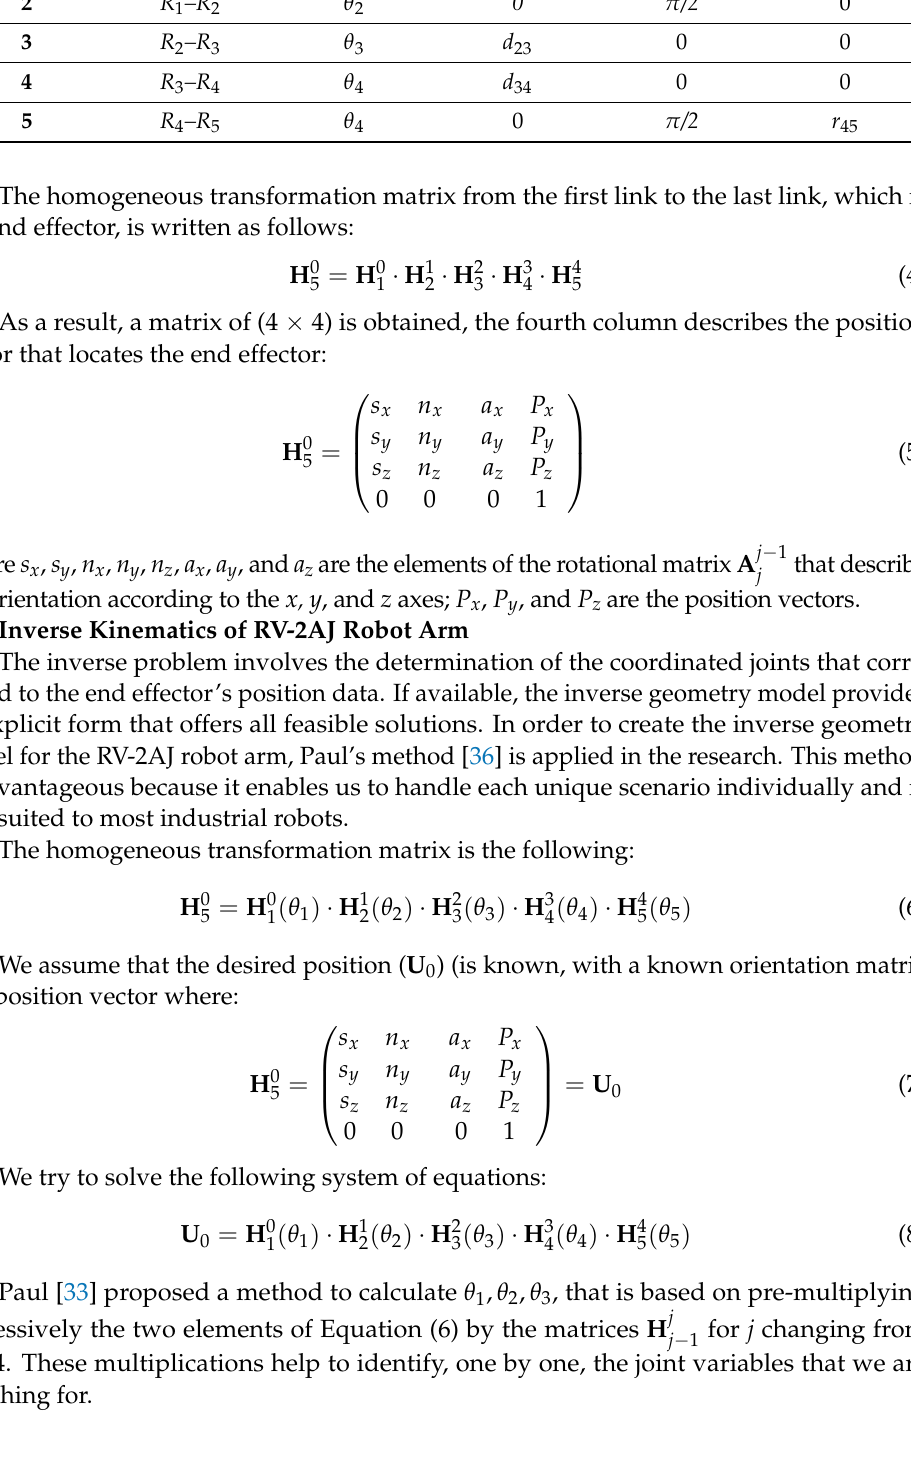
Table 2. Parameters of Denavit–Hartenberg with regard to the RV-2AJ robot arm. jth Joints Axes θ j d j α j r j 1 R 0 − R 1 θ 1 0 0 r 01 2 R 1 –R